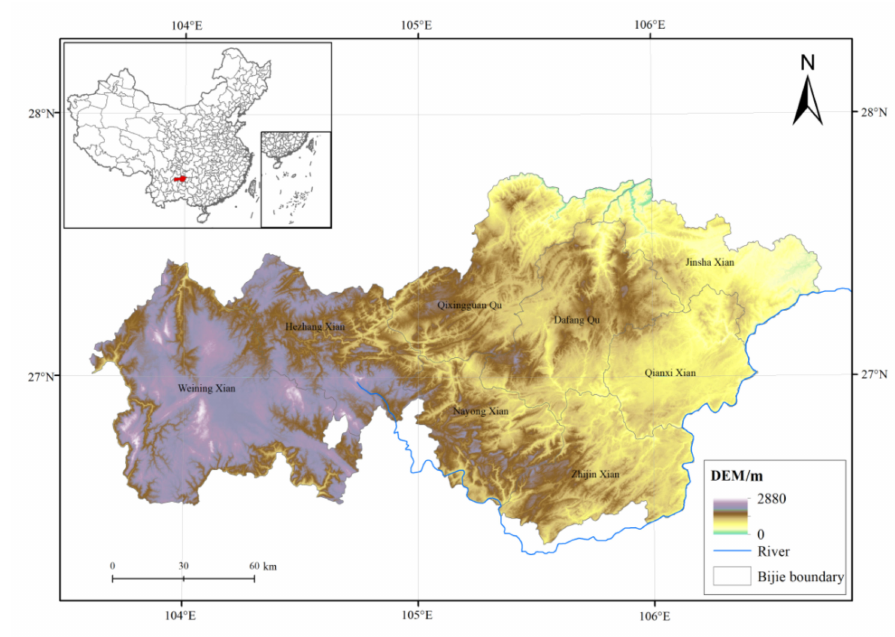
Figure 1. Location and topography of the study